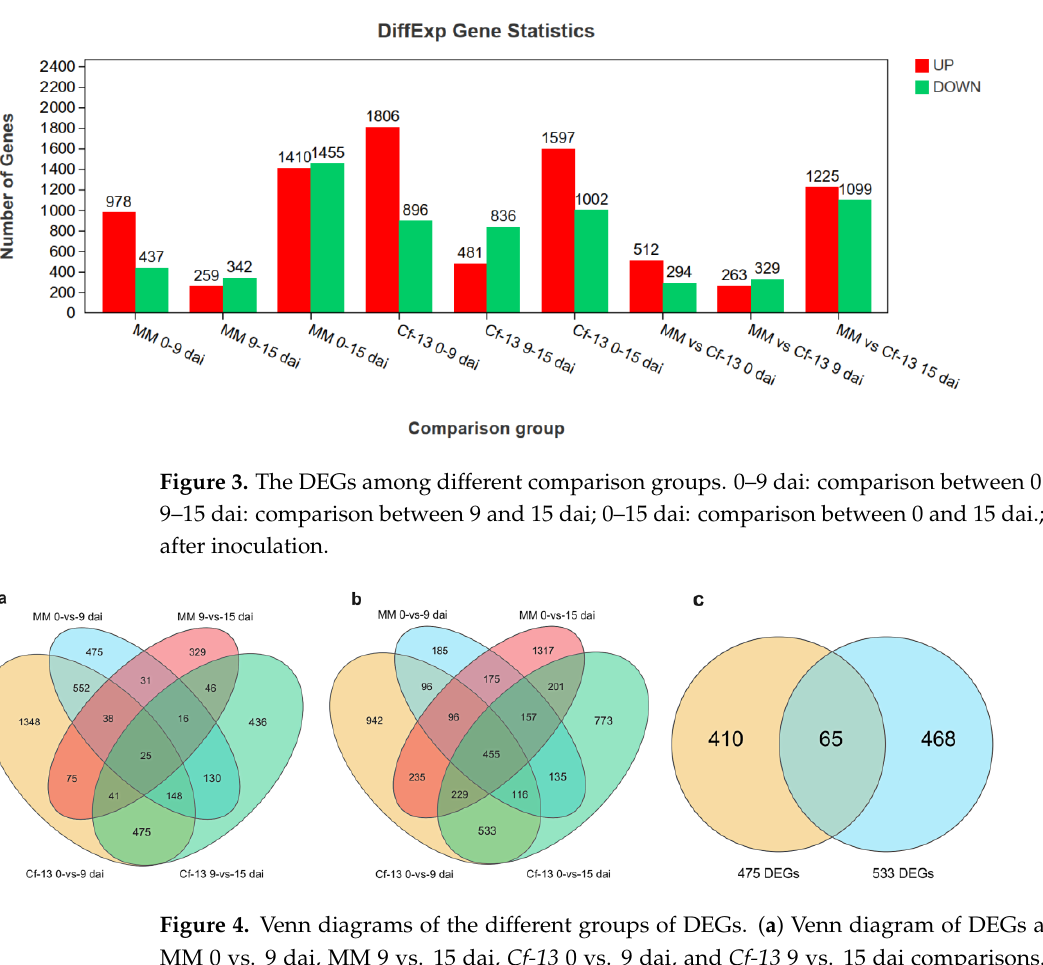
Figure 3. The DEGs among different comparison groups. 0 – 9 dai: comparison between 0 and 9 dai; 9 – 15 dai: comparison between 9 and 15 dai; 0 – 15 dai: comparison between 0 and 15 dai.; dai: days after inoculation.